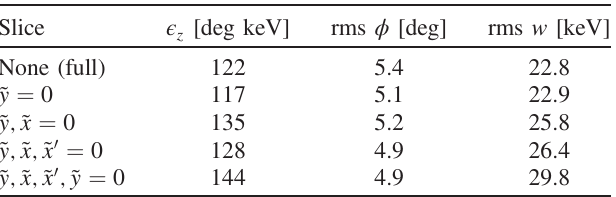
TABLE IV. Dependence of rms quantities of expected distri- bution on dimensionality of phase space slice. All slices are centered over the beam core. rms values are calculated with 1% threshold applied. For these results, 5,000,000 macroparticles are used to obtain good statistics in high-dimensional slices. The slice widths are twice as large as in measurement for the same reason.